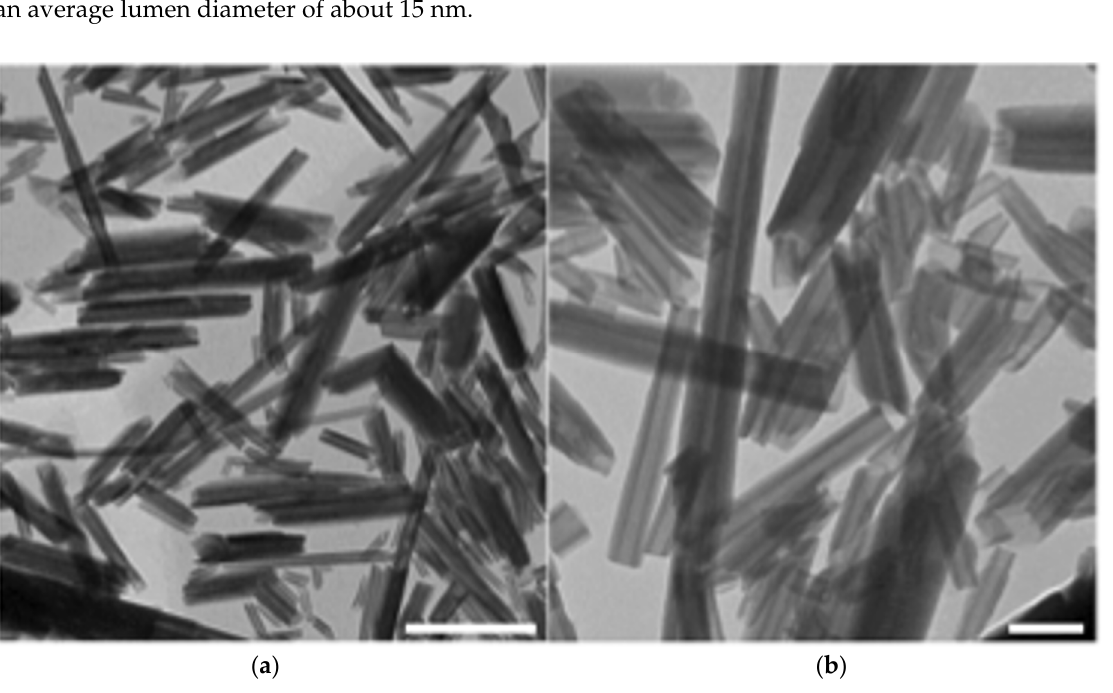
Figure 1. Typical transmission electron microscopy (TEM) images of halloysite clay nanotubes (HNTs): ( a ) panoramic image, showing the grade of polydispersity of HNT length (scale bar: 500 nm); and ( b ) high-magnification image, showing the hollow tubular structure of HNTs (scale bar: 100 nm).